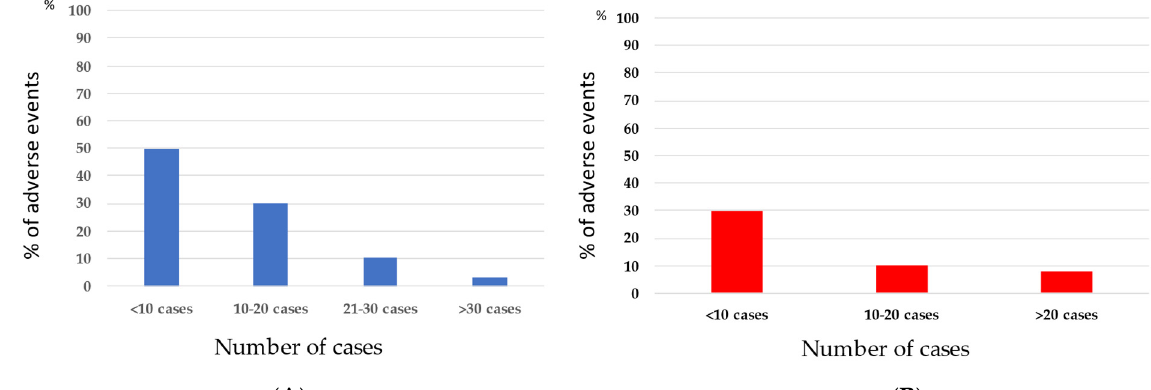
Figure 1. Caseload-dependent reduction in adverse events in EUS drainage of PFCs and CBD. Case-